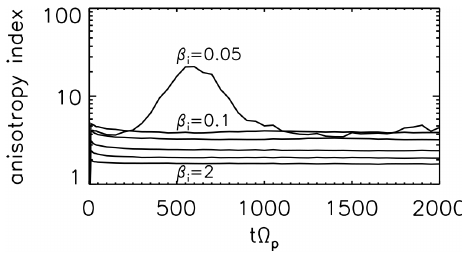
Figure 4. Anisotropy evolution for the data obtained by numeri- cal simulation at the values of ion beta β i = { 0 . 05 , 0 . 1 , 0 . 2 } in the < 3. wavenumber range 0 < kV A (cid:127) p